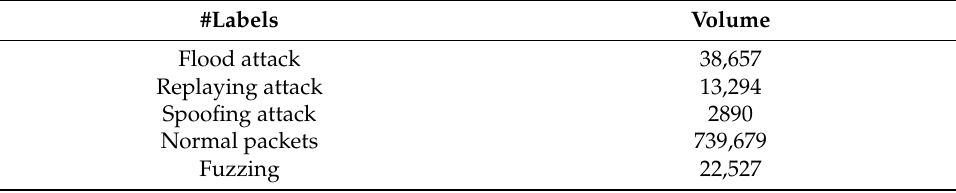
Table 3. Training datasets for each class.